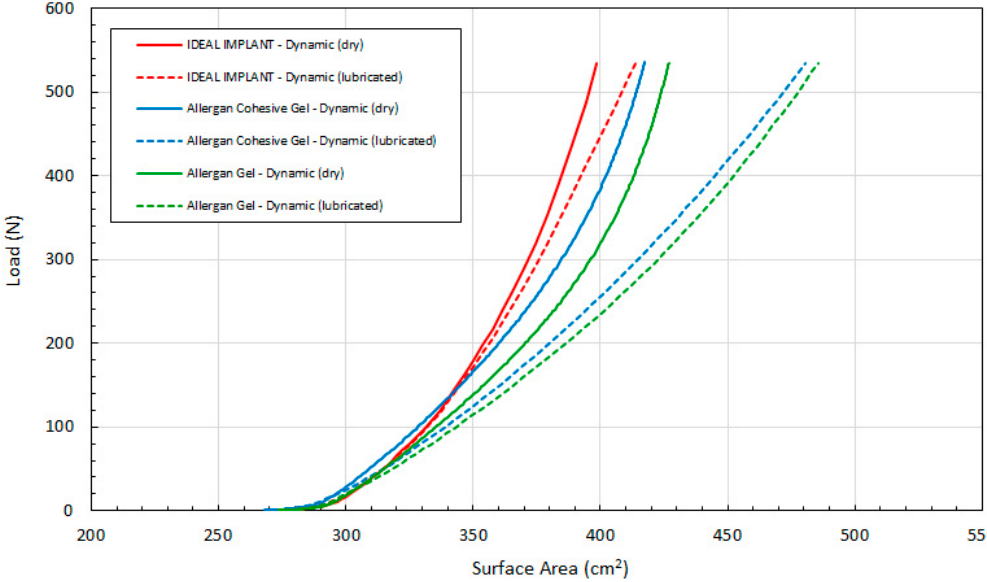
Figure 10. Load (F) as a Function of Implant Surface Area (A) for Dynamic Testing, Dry and Lubricated Platens.